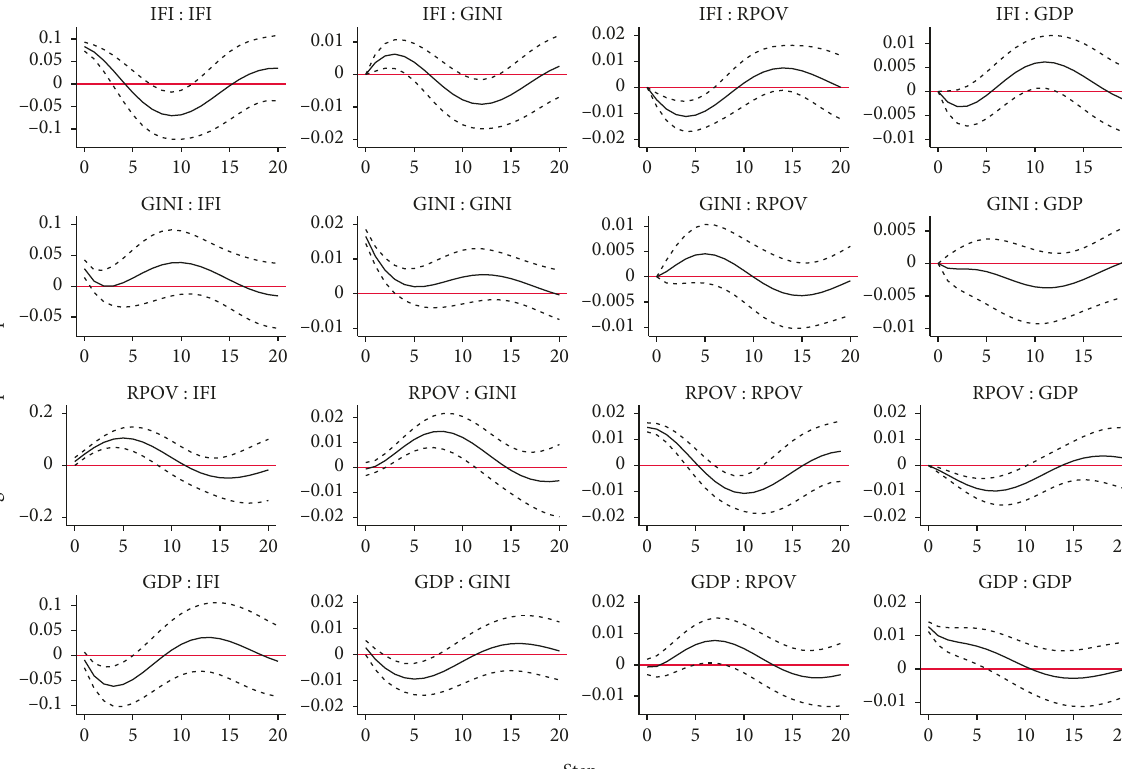
Figure 5: Impulse response function in the Western